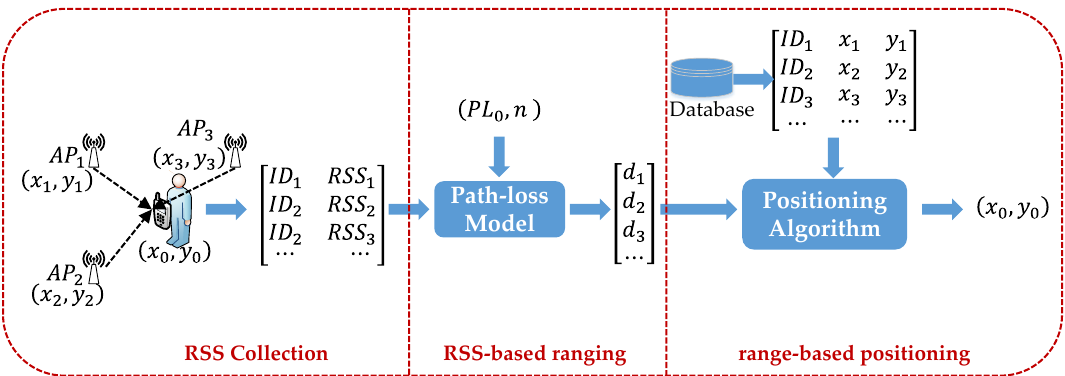
Figure 1. System model of range-based Bluetooth Low Energy (BLE) positioning.